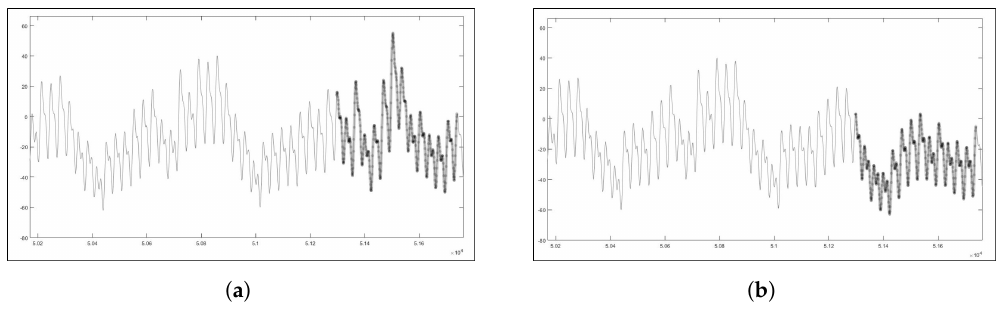
Figure 4. ( a ) power consumption trace when the sign bit is 1; ( b ) power consumption trace when the sign bit is 0.